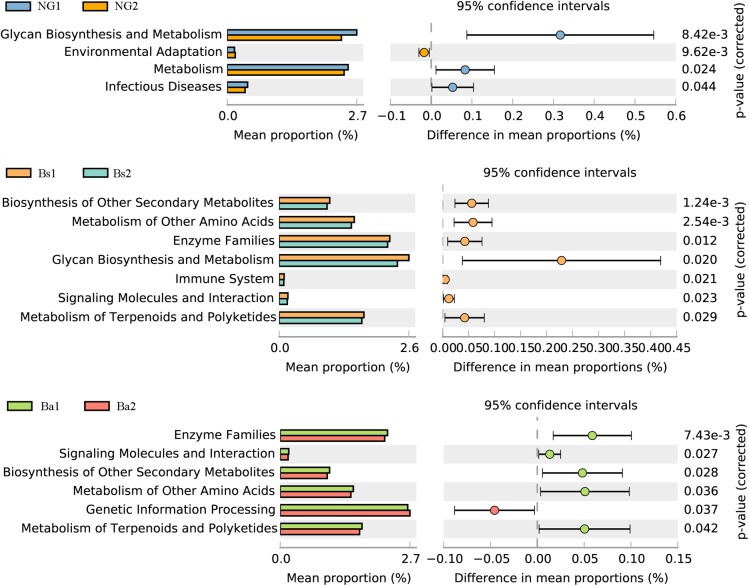
Functional genes of the intestinal microbiome which showed significant differences (P < 0.01) between NG(A), Bs(B), and Ba(C) groups at the phyla level.